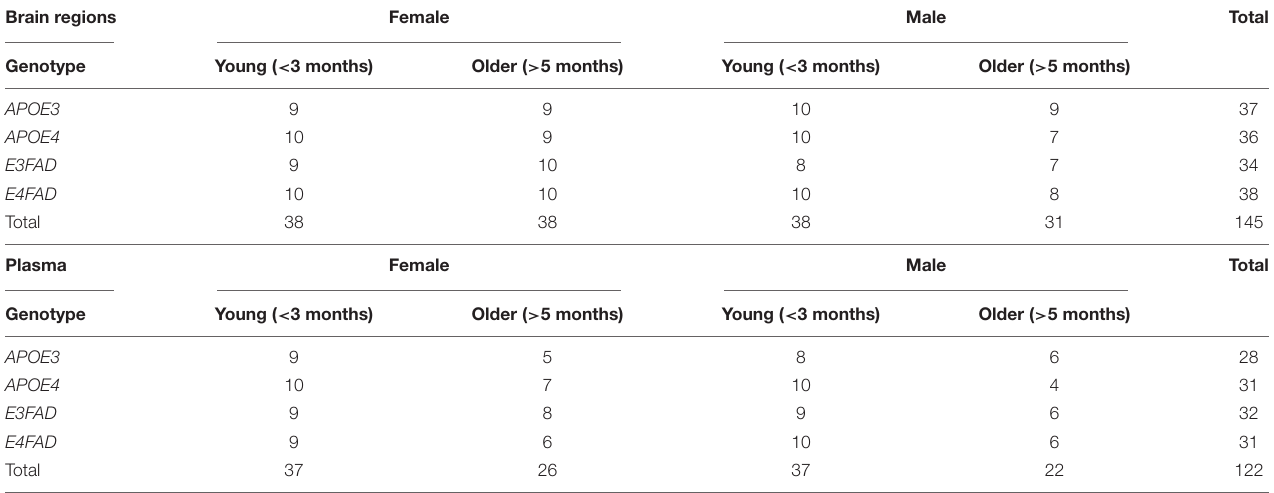
TABLE 1 | Animal groups. Brain